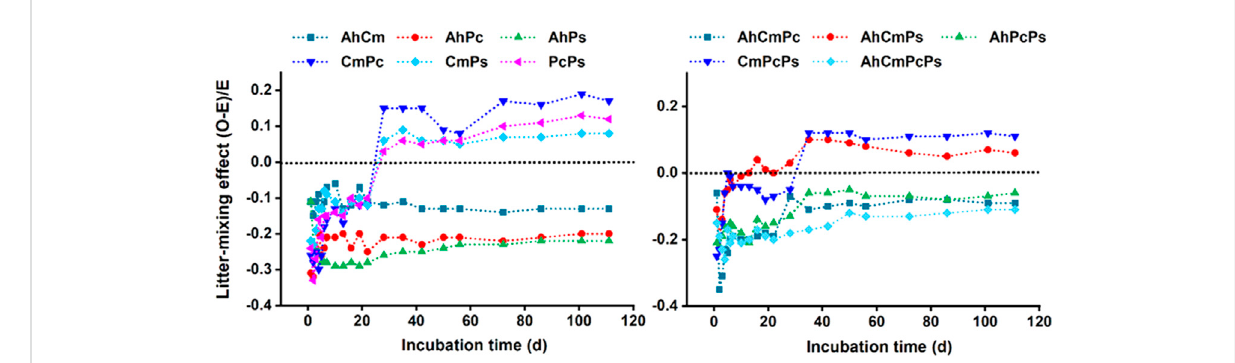
FIGURE 4 Dynamics oflitter-mixingeffects (LME)onCO 2 emission ratefortwospecies, threeand fourspeciesmixtures.Dottedlines indicatethepointat which observed values (O) equal to expected values (E).